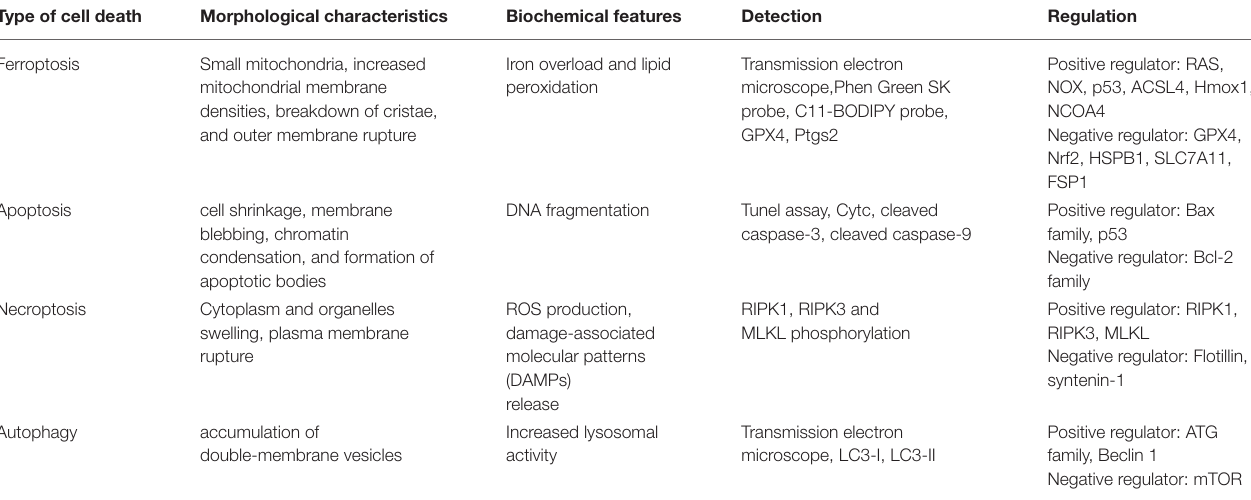
TABLE 1 | Characteristics of different types of cell